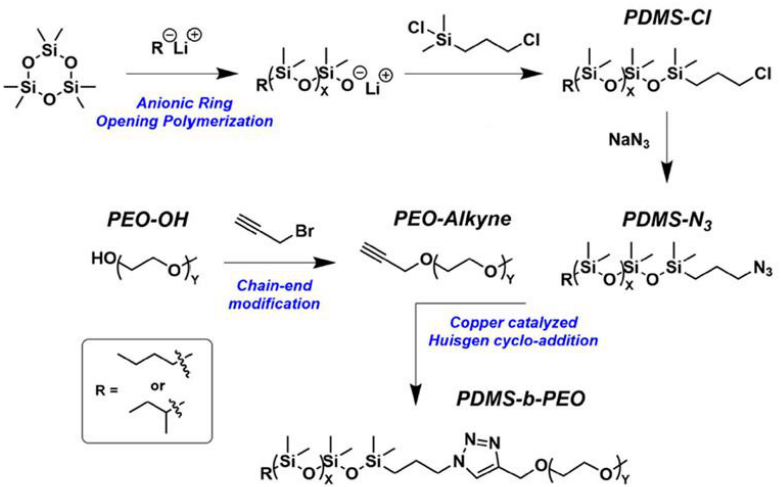
Figure 12. General synthesis procedure to obtain PDMS-b-PEO copolymers (adapted with permis- sion from Ref. [94]). 2019, Fauquignon, M)